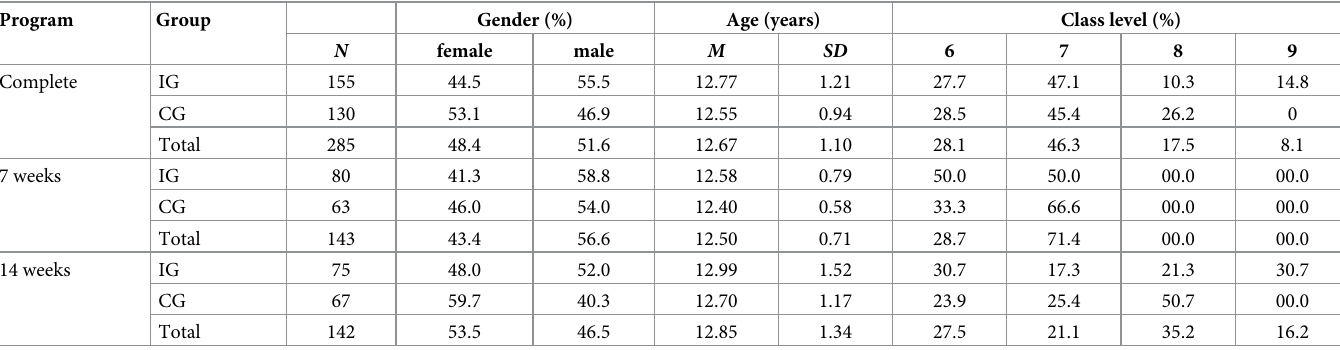
Table 1. Distribution of sample regarding gender, age and class